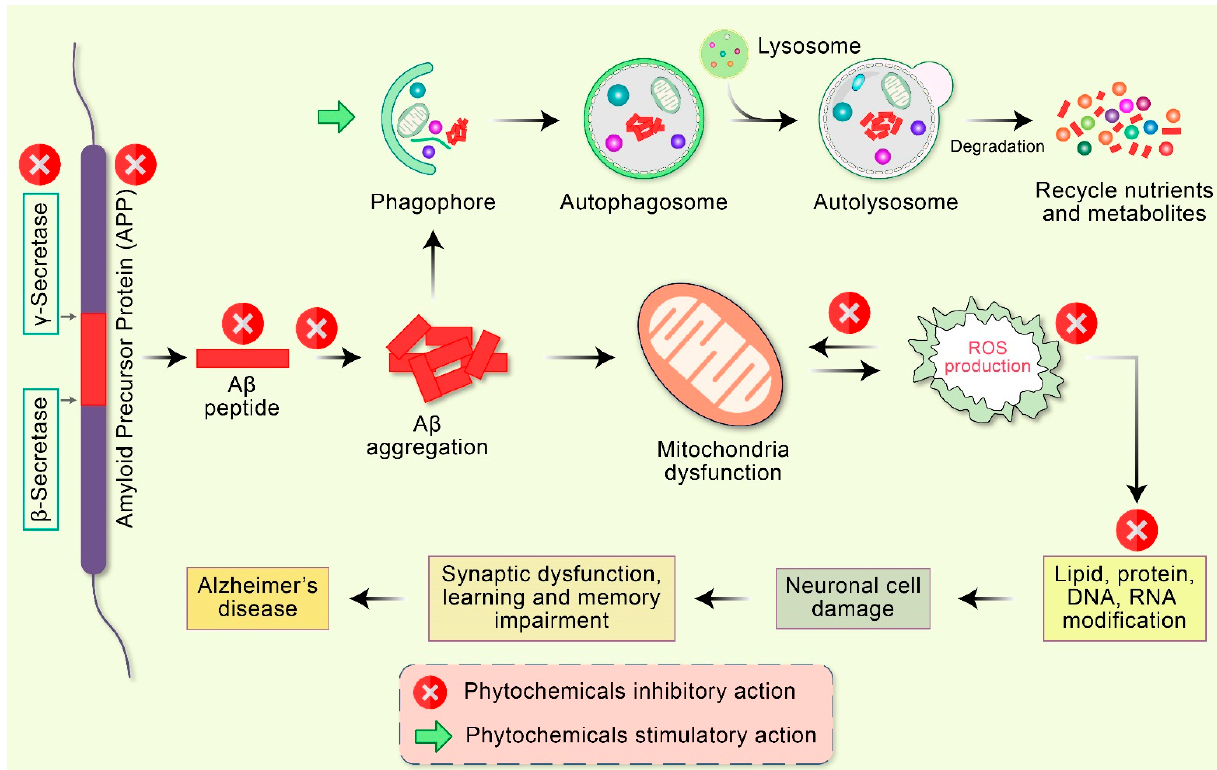
Figure 4. Emerging potential therapeutic targets of phytochemicals in mitochondrial dysfunction and AD pathogenesis. Abnormal APP is proteolyticlly cleaved by β - as well as γ -secretase leading to the accumulation of extracellular amyloid- β (A β ). Deficient clearance of A β or A β production increases aggregation, leading to the accumulation of a diversity of A β assemblies. Accumulation of A β directly interrelates with mitochondria as well as ROS generation with different intracellular pathways. These oxidative stress reactions lead to the impairment of neuronal synapses and dendrite function with multifactorial mechanisms, in addition to neurological degeneration and dysregulation of synaptic function in the regions of the brain implicated in learning and memory impairment in AD. Additionally, A β aggregates are degraded by autophagy via the stimulatory action of phytochemicals.